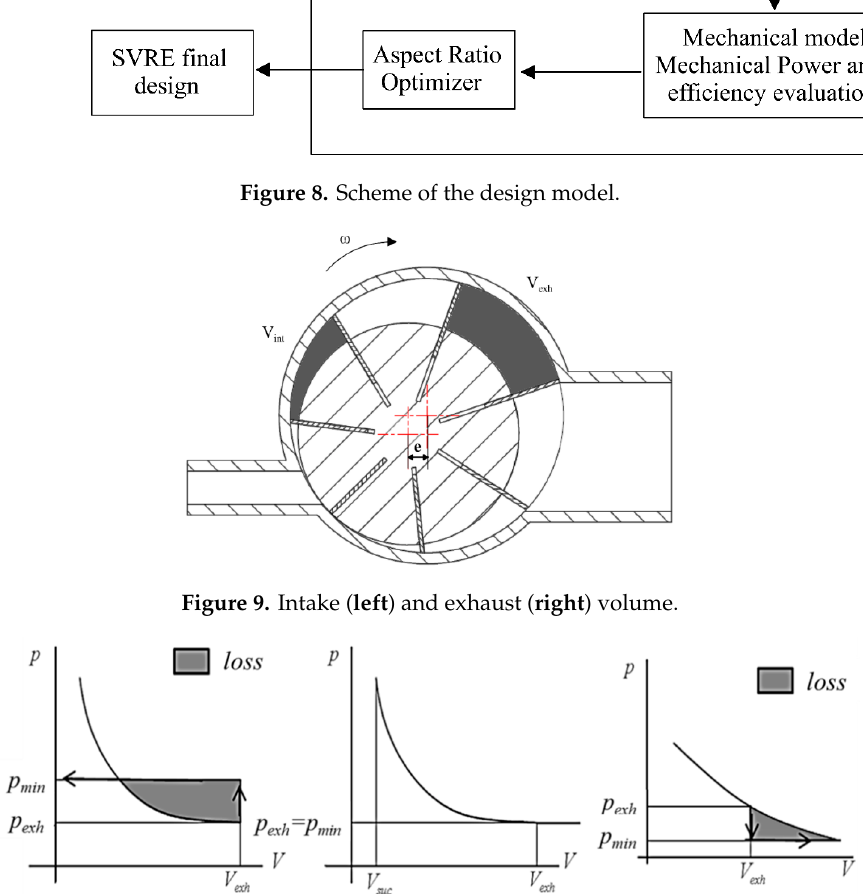
Figure 10. Different kinds of exhaust loss at the expander outlet .